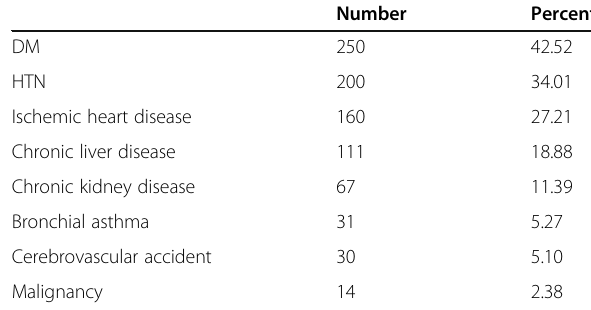
Table 2 Comorbidities among study